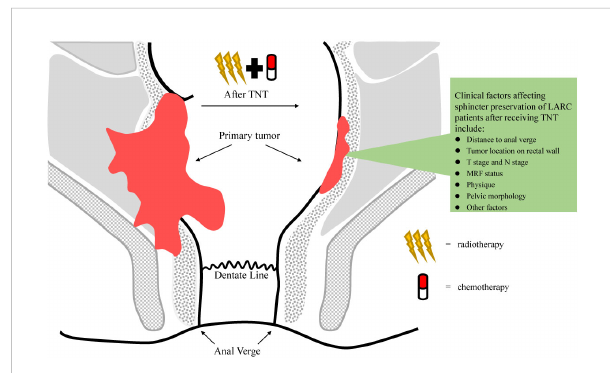
FIGURE 1 Tumor regression in patients with local advanced rectal cancer (LARC) receiving total neoadjuvant treatment